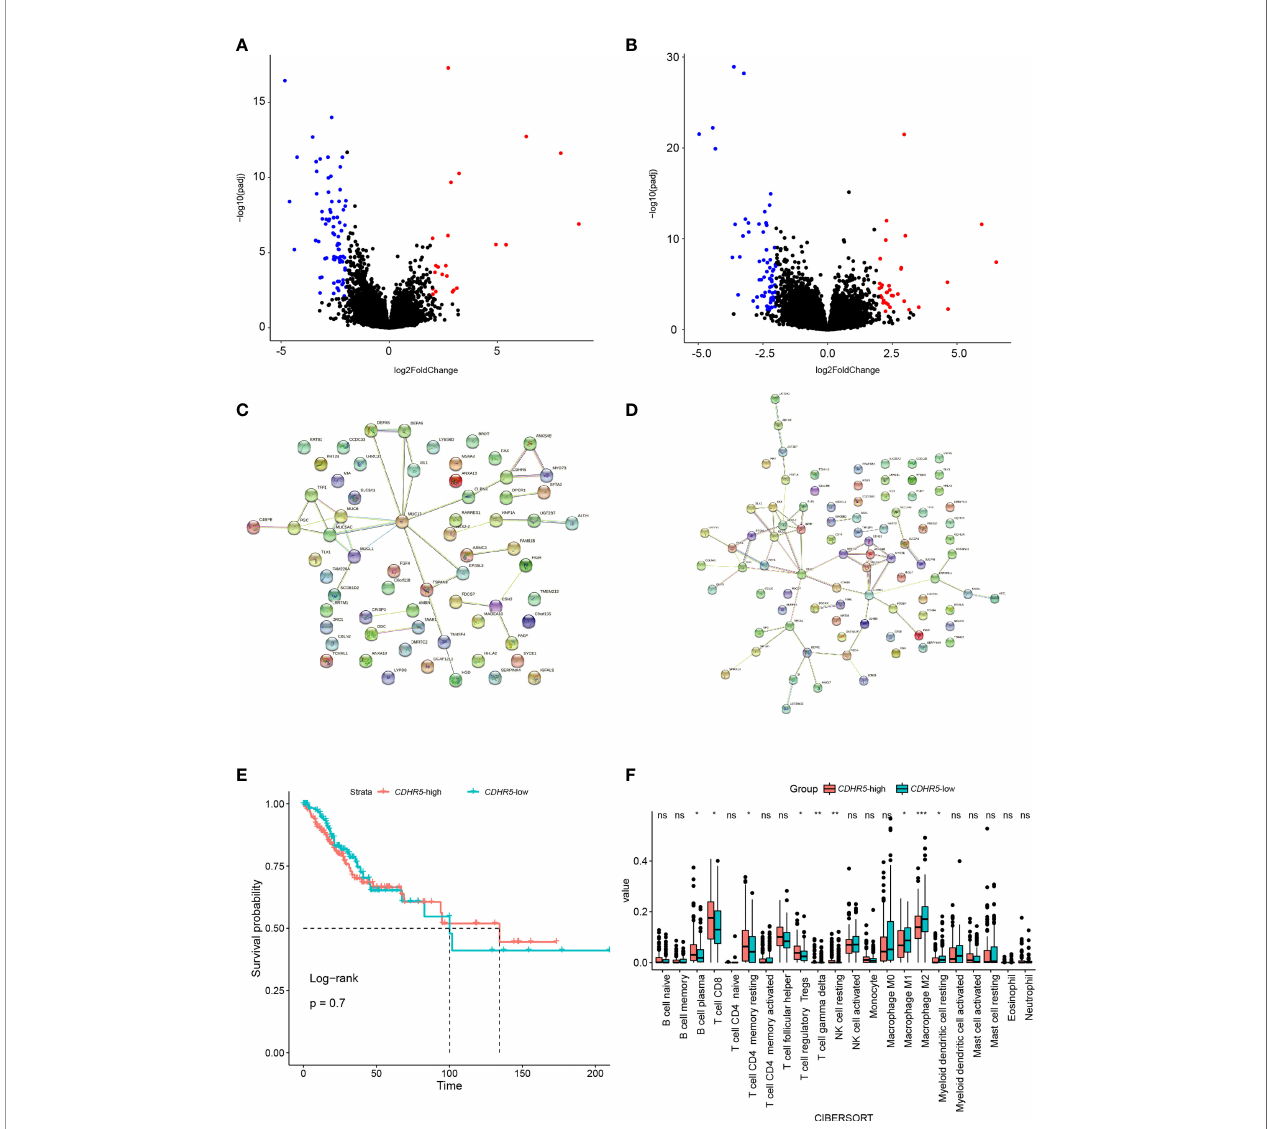
FIGURE 7 | DEGs analysis between samples with and without DDR alteration (A) , and samples with high and low hypoxia scores (B) , respectively. The protein – protein interactions (PPI) network of DDR (C) and hypoxia score (D) , respectively. (E) The overall survival analysis between the groups with high or low expression of hub gene CDHR5 . (F) Analysis of tumor in fi ltrated lymphocytes in cervical cancer samples with high and low CDHR5 expression. *p < 0.05, **p < 0.01, ***p < 0.001, ns, not signi fi